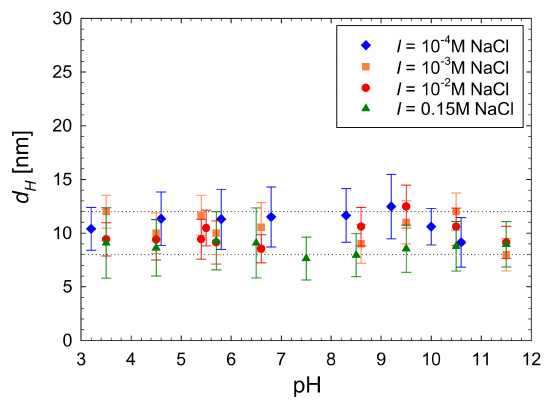
Figure 6. The dependence of the hydrodynamic diameter of the P-Arg molecule on pH obtained experimentally from DLS measurements. The dotted lines correspond to the average d H value equal to 12 and 8 nm for 10 − 4 M and 0.15 M NaCl, respectively. The measurements were performed at T = 298